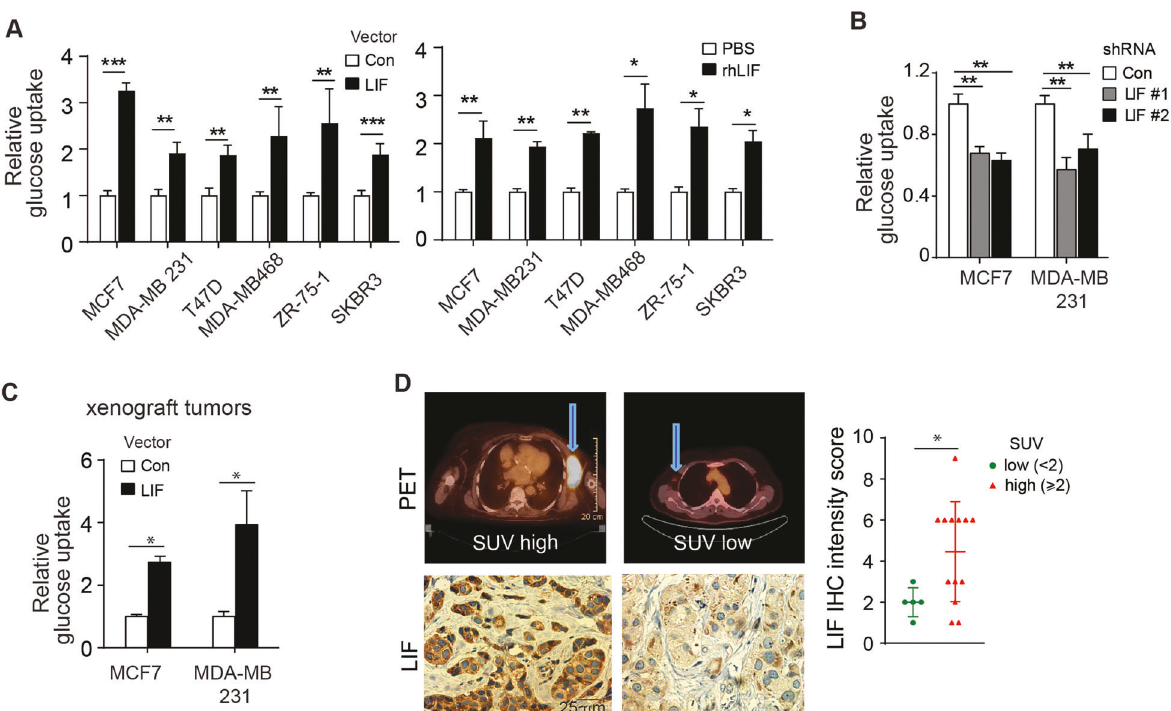
Fig. 1 LIF promotes glucose uptake in breast cancer cells. A Ectopic LIF expression (left panel) as well as treatment with recombinant human LIF protein (rhLIF, 100 ng/ml for 6 h; right panel enhanced glucose uptake in breast cancer cell lines, including MCF7, MDA-MB 231, T47D, MDA-MB 468, ZR-75-1 and SKBR3 cells as determined by measuring the uptake of 3 H-2-DG in cells. The overexpression of LIF in these cells was shown in Supplementary Fig 1A. B Knockdown of endogenous LIF by two different shRNAs reduced glucose uptake in MCF7 and MDA-MB 231 cells. The knockdown of LIF expression in these cells was shown in Supplementary Fig 1B. C Ectopic LIF expression increased glucose uptake in the xenograft tumors formed by MDF7 and MDA-MB 231 cells as determined by measuring the uptake of 3 H-2-DG in tumor tissues. D . High LIF expression was associated with the increased 18 F-FDG uptake in human breast tumors. Left panels: representative PET scan data and images of LIF IHC staining. SUV: standardized uptake value. In A – C , n = 3/group; in D , n = 18 for total patient samples. *: p < 0.05; **: p < 0.01; ***: p < 0.001; unpaired Student ’ s t -test for A – C ; correlation in D was calculated by Spearman ’ s Rho correlation